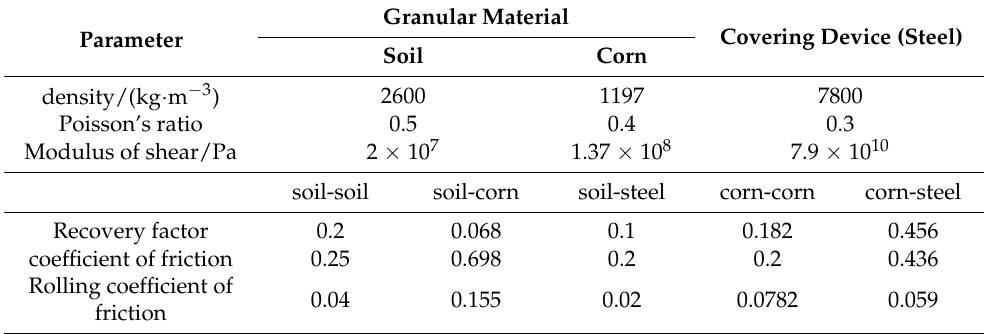
Table 1. Basic Parameters of Discrete Element Models for Granular Materials and Covering Devices. Granular Material Covering Device (Steel) Parameter Soil